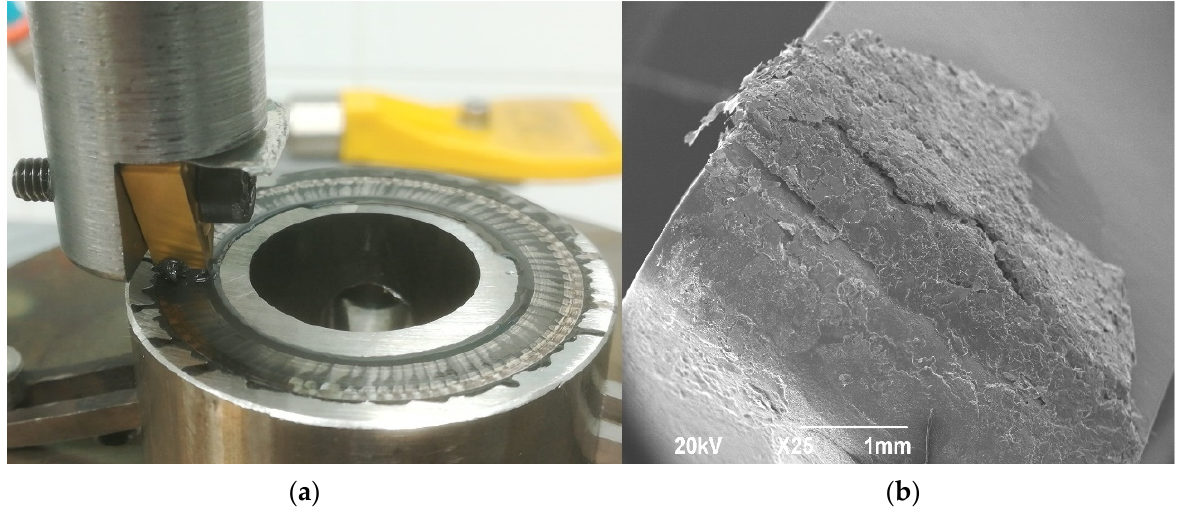
Figure 7. ( a ) General view of the Cu-Ni 70/30 alloy-tool friction system. ( b ) Detail of the grease layer formed by combination of the cutting oil and Cu-Ni particles.